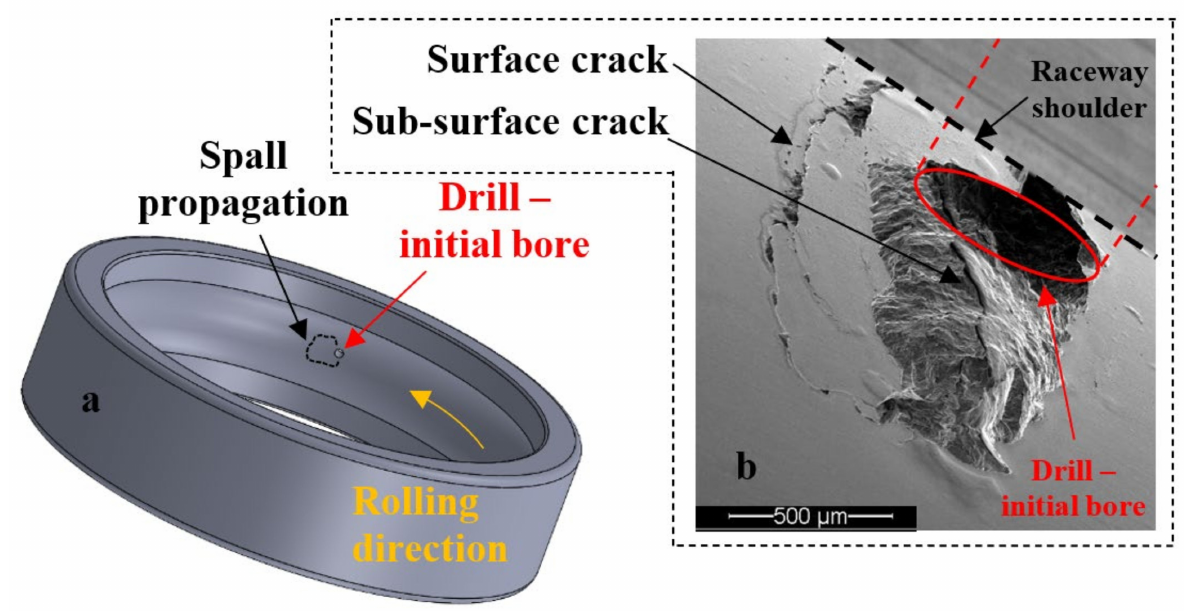
Figure 8. ( a ) Schematic drawing of the outer raceway with the initial bore. ( b ) Spall generated from the initial